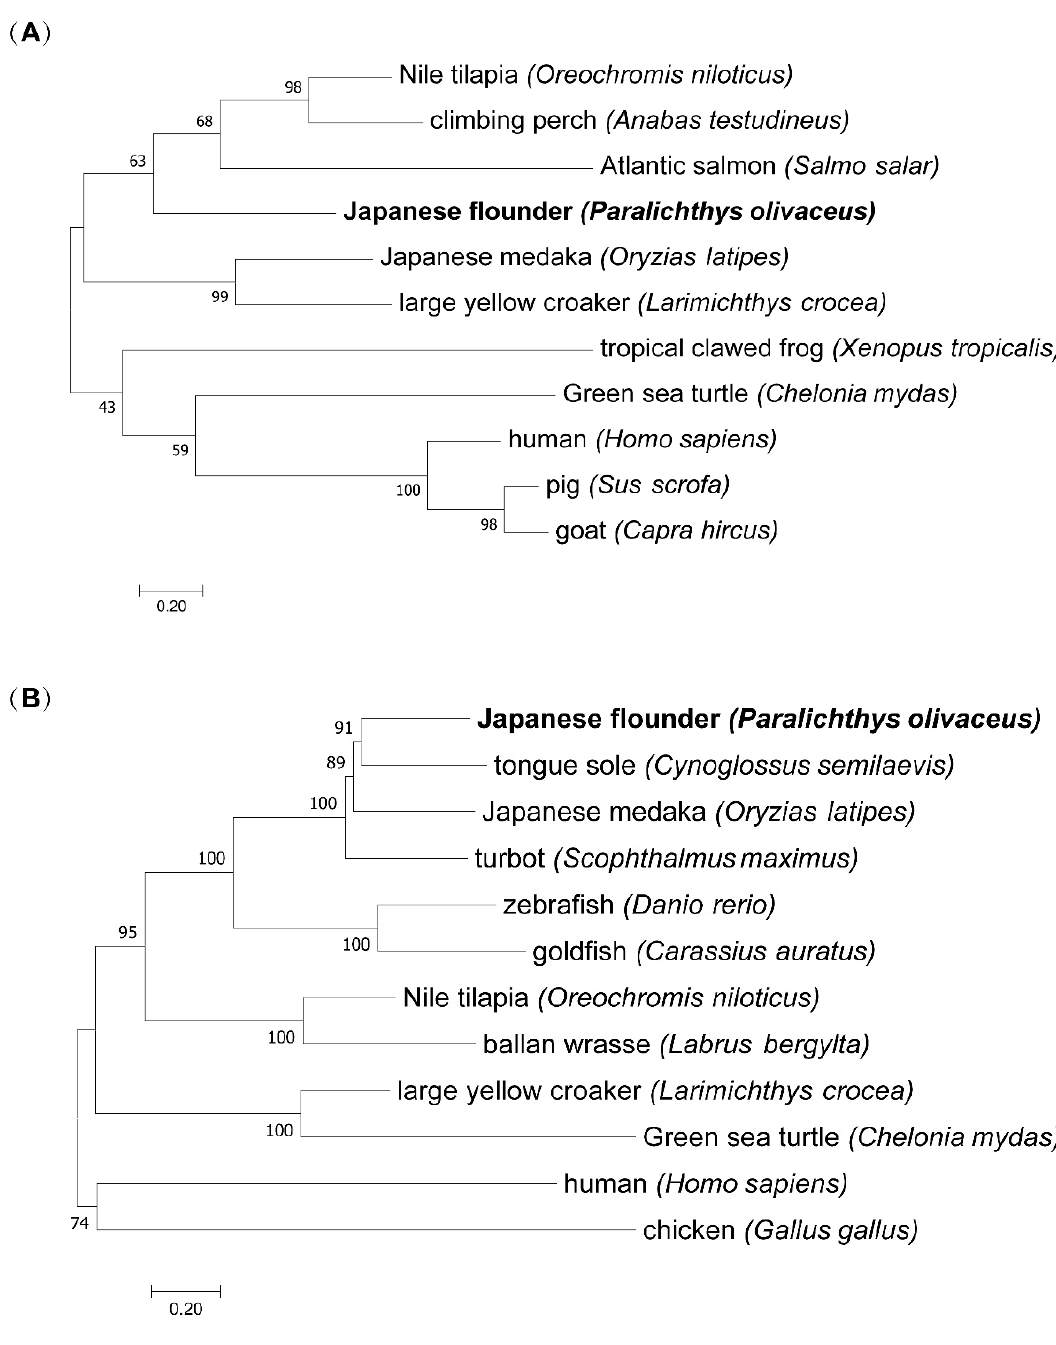
Figure 3. ( A ) Bad phylogenetic analysis. The accession numbers of Bad protein are listed in Table S9. ( B ) EPAS1 phylogenetic analysis. The accession numbers of EPAS1 protein are listed in Table S10. The numbers in the branches represent the percentage of the associated taxa clustered together in the bootstrap test (1000